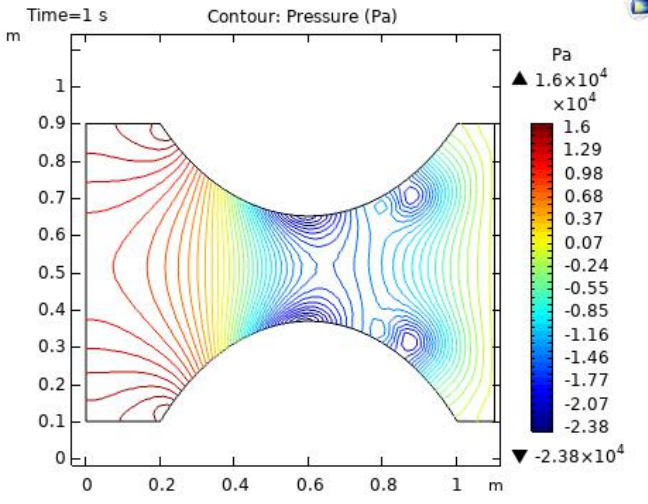
Figure-16. The pressure profile at t = 1 s.